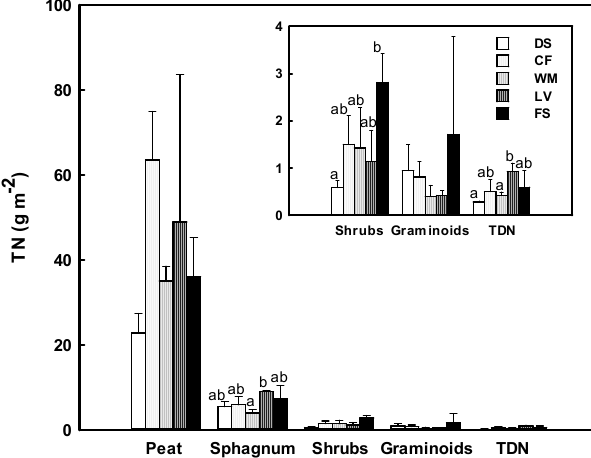
Figure 3. Total nitrogen content (mean ± SD, n = 3) in the ecosys- tem pools investigated standardized to the peatland surface area. The Sphagnum pool contained mass from 0 to 5cm below surface. Letters a and b – significant differences in the mean values of the sites at each pool (one-way ANOVA, Tukey test). A bar without a letter – no significant difference. Site abbreviations as in Fig.